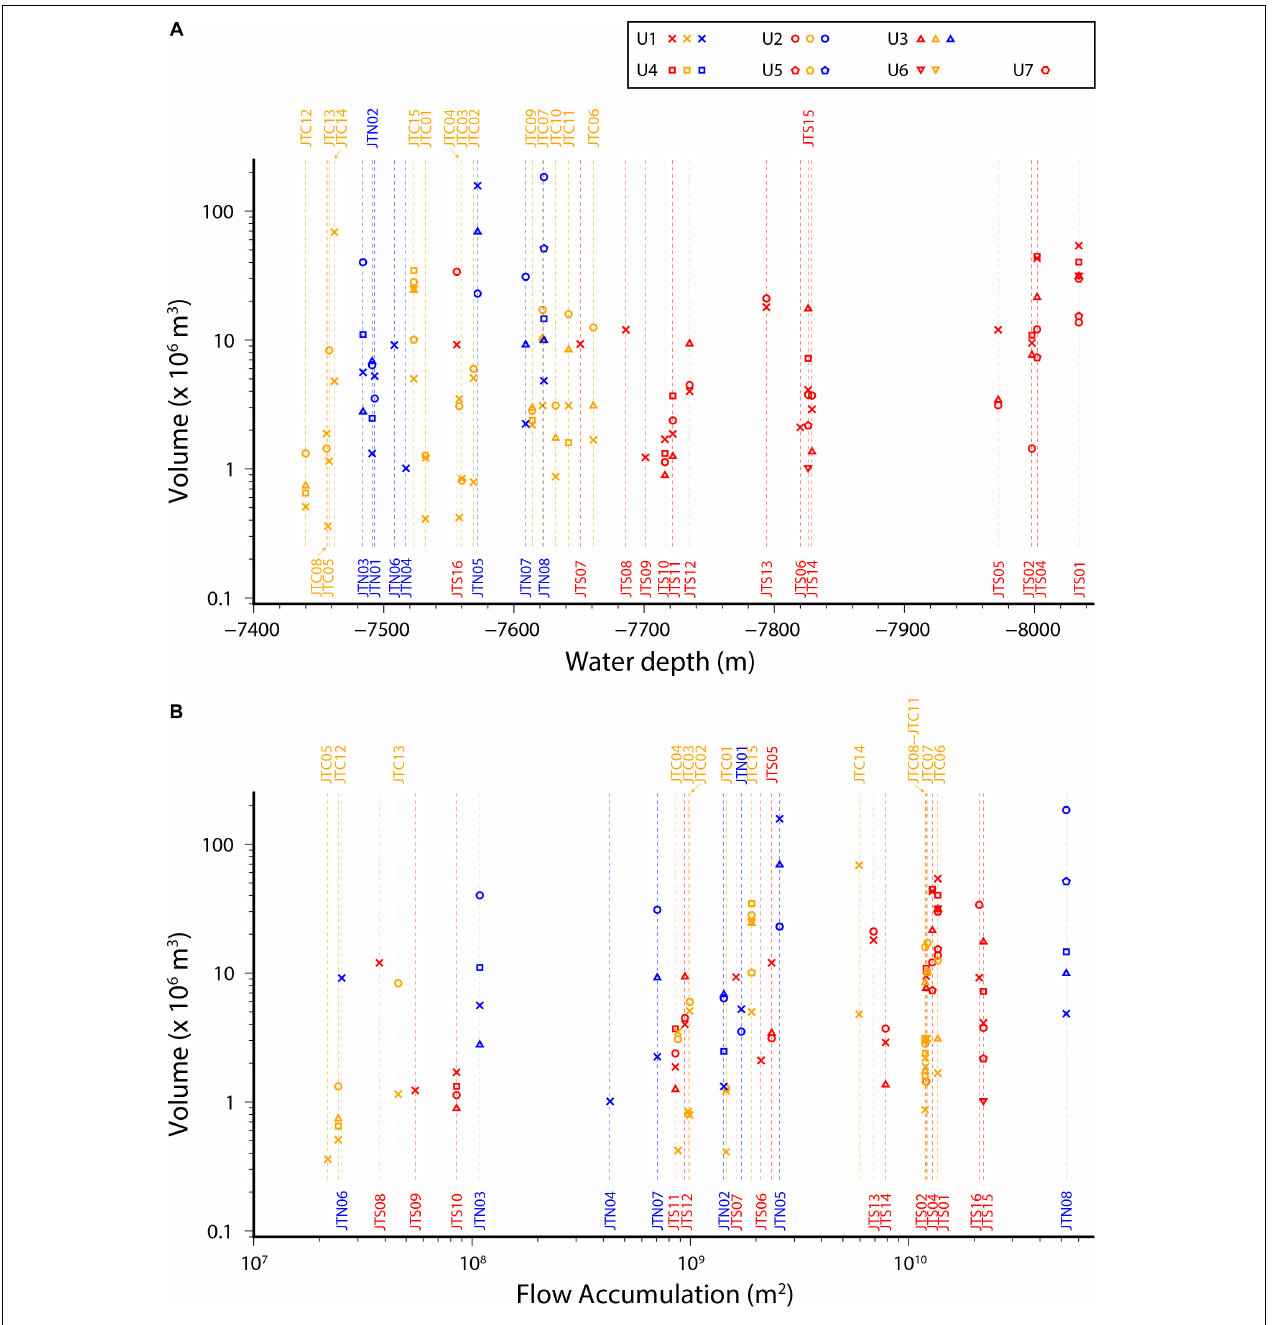
FIGURE 8 | (A) Relationship between volume of event deposit and modern water depth of depocenter at a given trench-fill basin. (B) Relationship between volume of event deposit and modern flow accumulation of modern depocenter at a given trench-fill basin. Red, orange, and blue plots represent the basins in the southern, central, and northern Japan Trench, respectively. Cross, circle, triangle, square, pentagon, inverted triangle, and hexagon plots represent the volumes of SBP units U1 (and uppermost deposits “NaN” in Table 2 ), U2, U3, U4, U5, U6, and U7, respectively. The data with volumes less than 0.3 × 10 6 m 3 are not